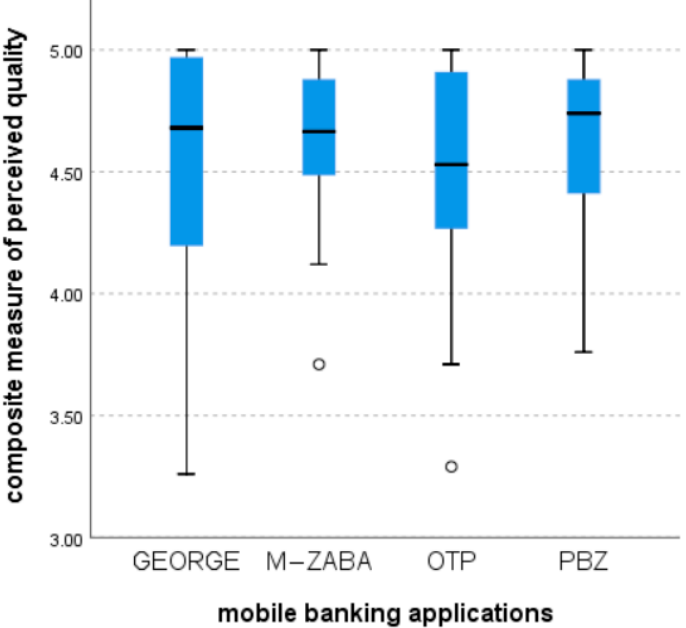
Figure 3. Comparison of item means per mobile banking applications.